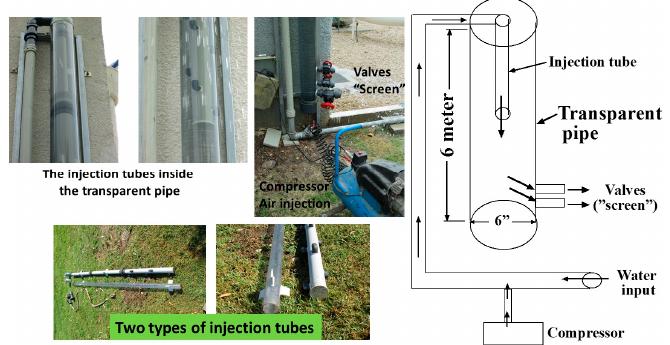
Figure 2. The air bubble pilot (schematic layout).